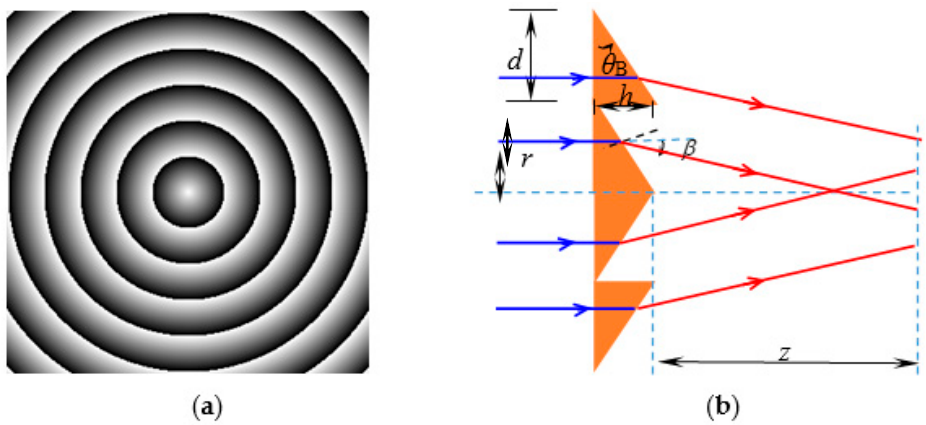
Figure 2. ( a ) A hologram for realizing the positive axicon, ( b ) the central profile of the